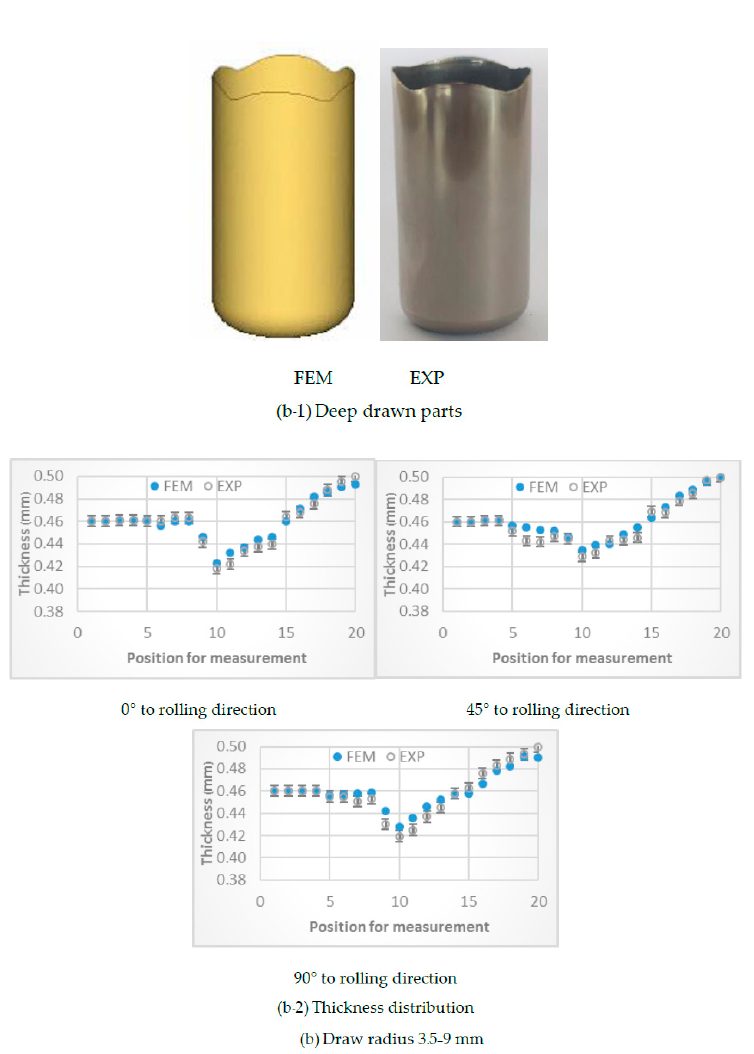
Figure 13. Comparison of theoretical and experimental results of multi draw radius die. (DR: 2.75; Ø initial blank: 110 mm): ( a ) Draw radius 3.5-7 mm; ( b ) Draw radius 3.5-9 mm.